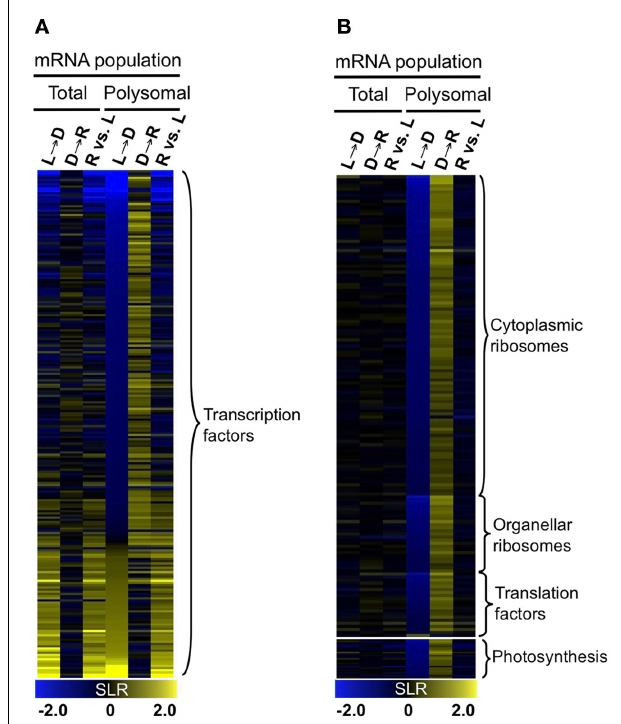
FIGURE 7 | Dynamics of transcript accumulation and translational status of mRNAs encoding proteins for transcription factors, translation machinery, and photosynthesis. (A) Heatmap of mRNA encoding transcription factors. Colors indicate increase (yellow), decrease (blue), or no-change (black) in mRNA abundance. (B) Heatmap of mRNA encoding components of cytosolic and organellar ribosomes, translation factors, and photosynthesis. Gene lists for (A,B) are provided inTable S1D in Supplementary